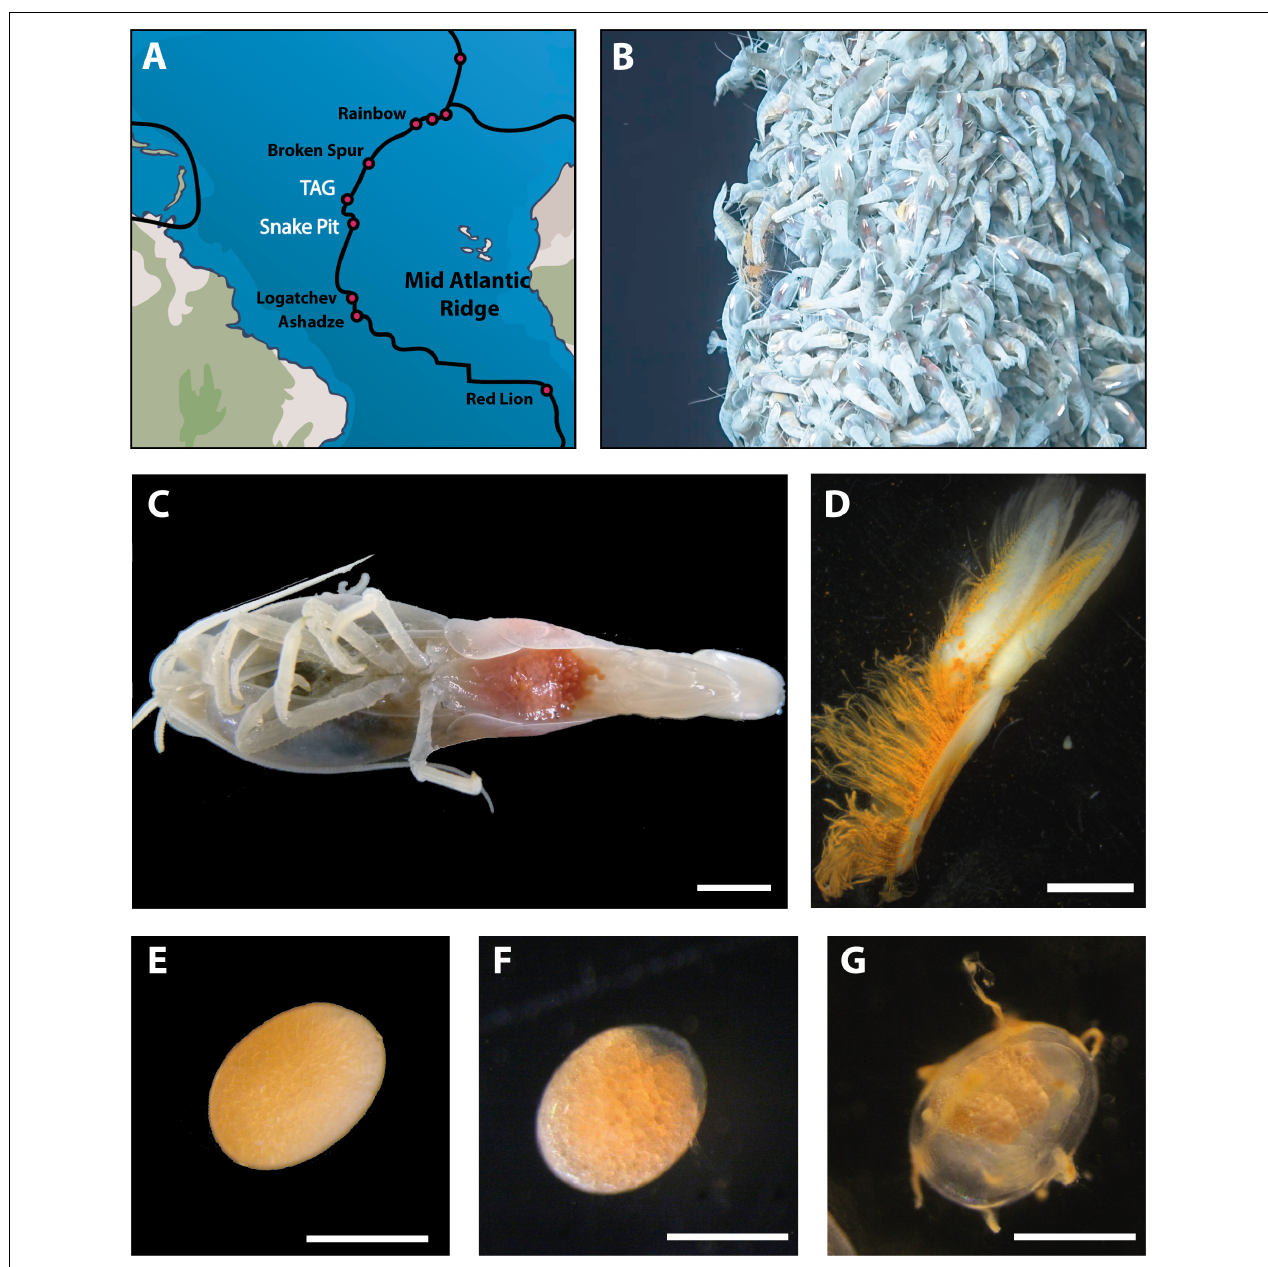
FIGURE 1 | Sampling and dissection procedures. (A) Geographic location of hydrothermal vent sites where Rimicaris exoculata are present (black) and where brooding females were sampled (white). (B) Example of a shrimp aggregate where brooding females were collected at TAG vent field. (C) Rimicaris exoculata brooding female holding eggs between pleopods under the abdomen; scale bar = 5 mm. (D) First pleopod with modified setae dissected from a brooding female; scale bar = 2 mm. Single eggs (E) at early stage (F) middle stage (G), and late stage of development; scale bars = 0.5